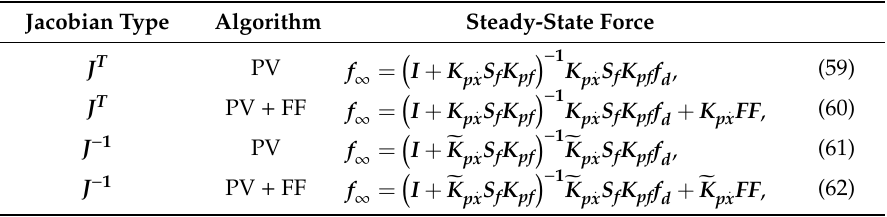
Table 4. Response force of the control force with inner velocity